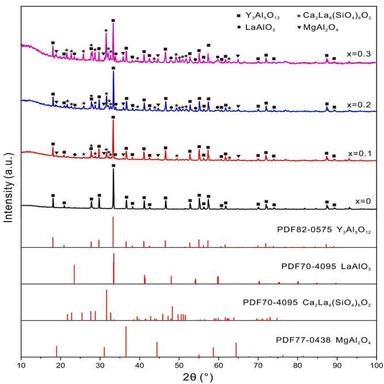
XRD patterns of (Y1-xLax)3Al5O12 (x = 0, 0.1, 0.2, 0.3) samples after CMAS corrosion at 1250 ◦C for 5 h.